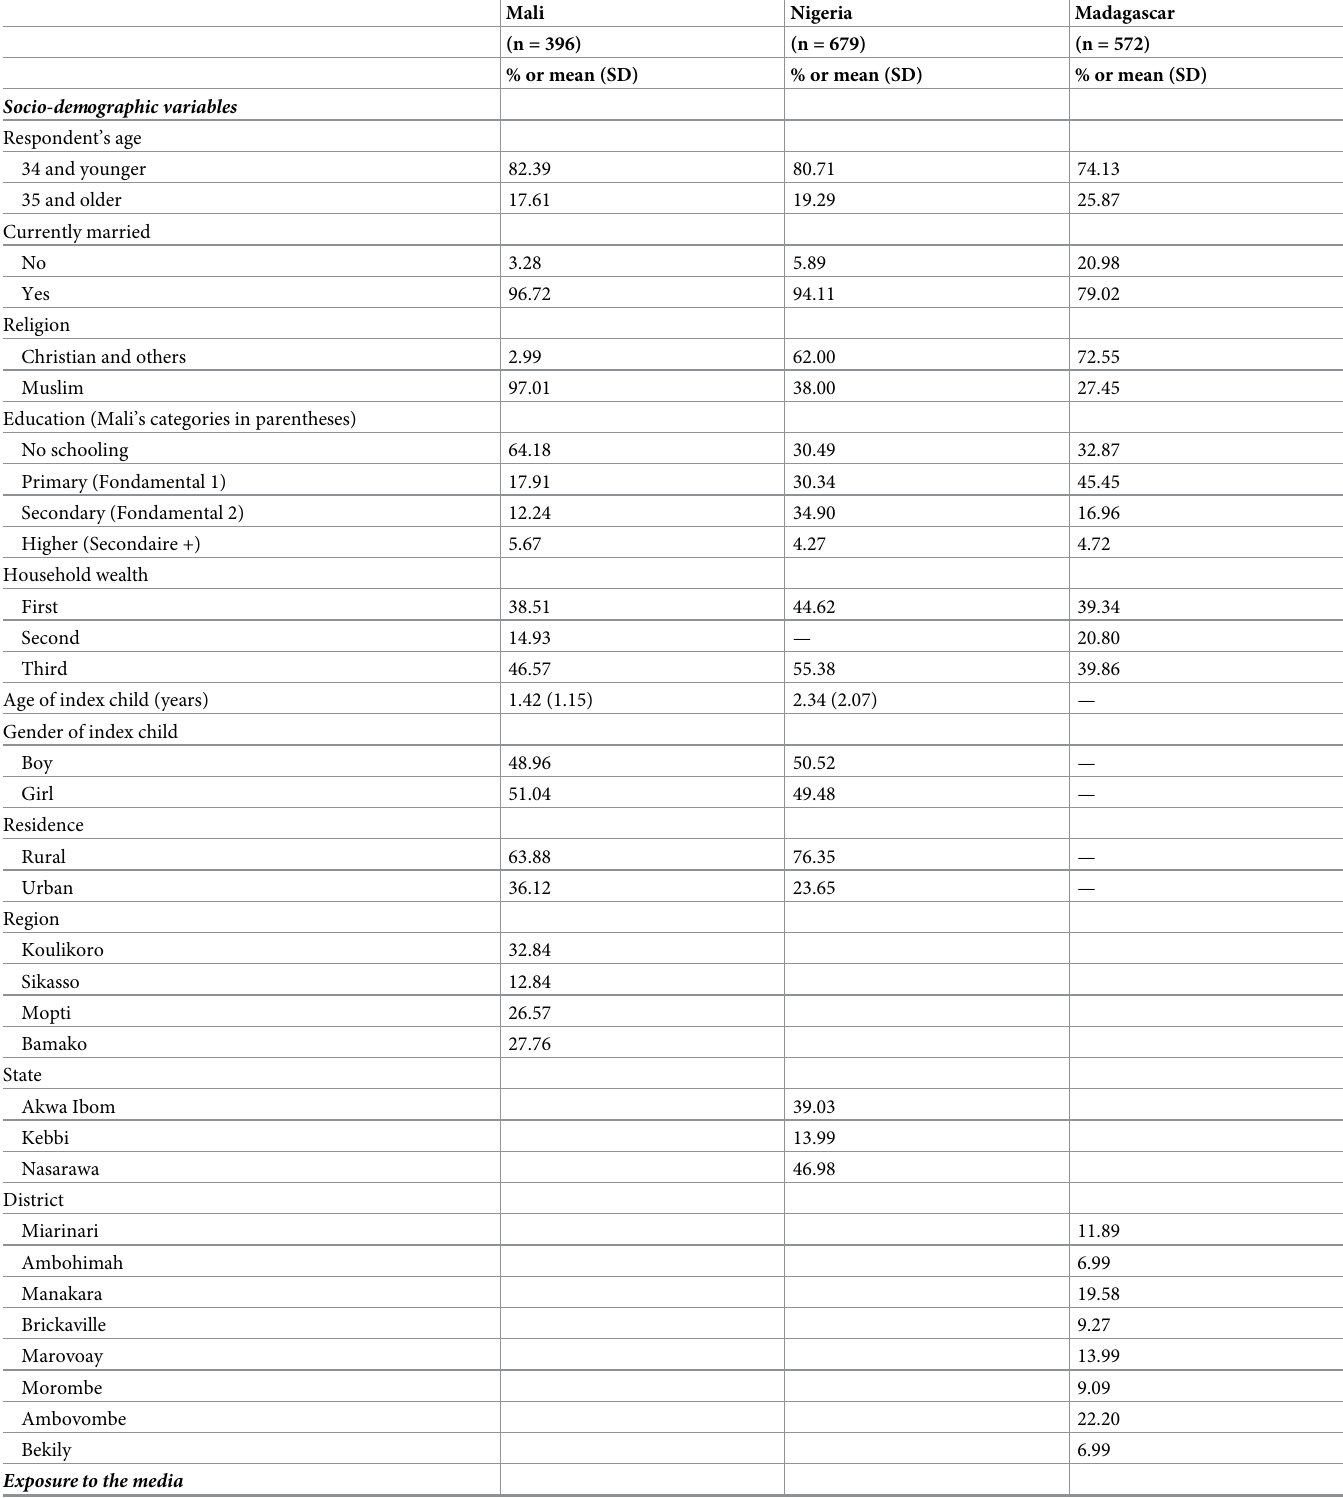
Table 1. Sample distribution by caregiver’s